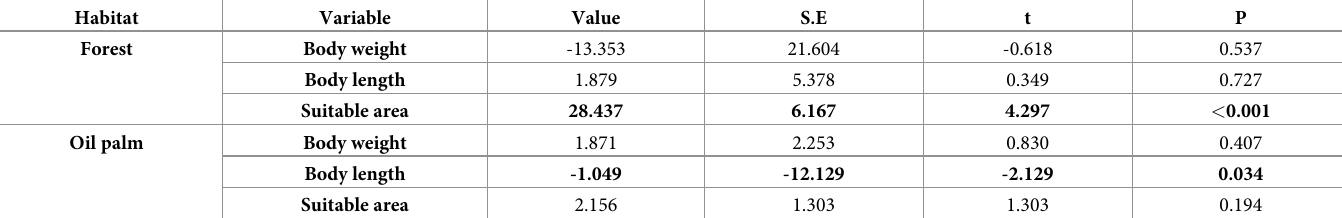
Table 3. GLS model outcomes presenting the effect of body weight, body length, and the size of suitable areas, on the number of individuals estimated in each type of habitat.